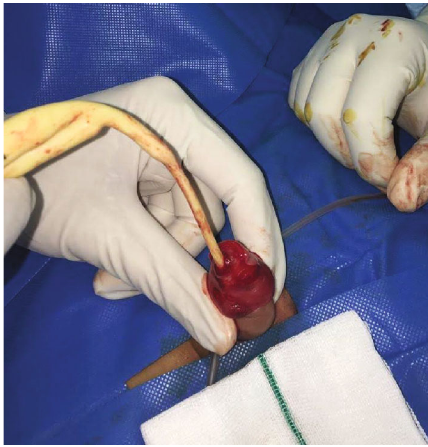
Figure 1: Amputated glans and complete injury of the urethra.